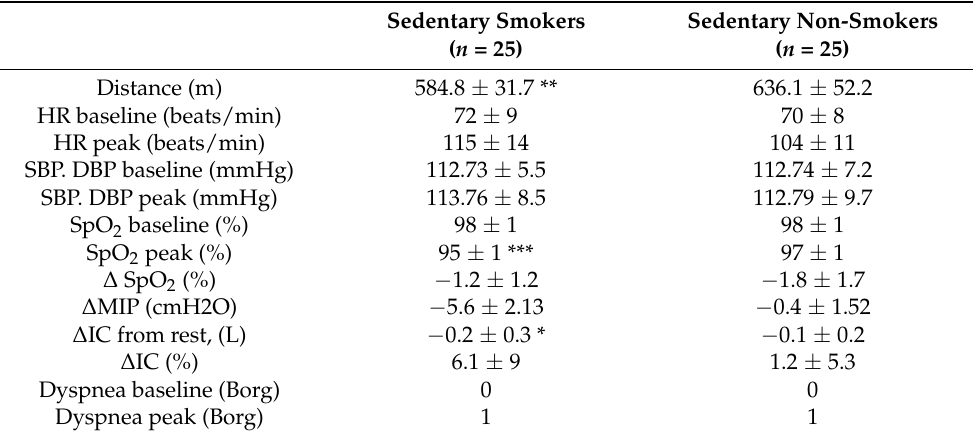
Table 2. Physiological response to the 6-MWT in sedentary smokers and non-smokers.